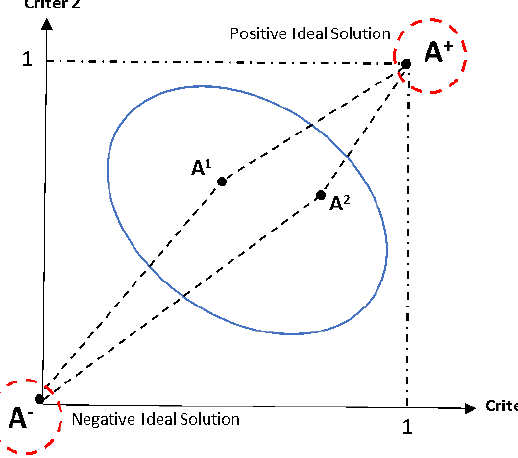
Figure 2. The main idea of TOPSIS technique